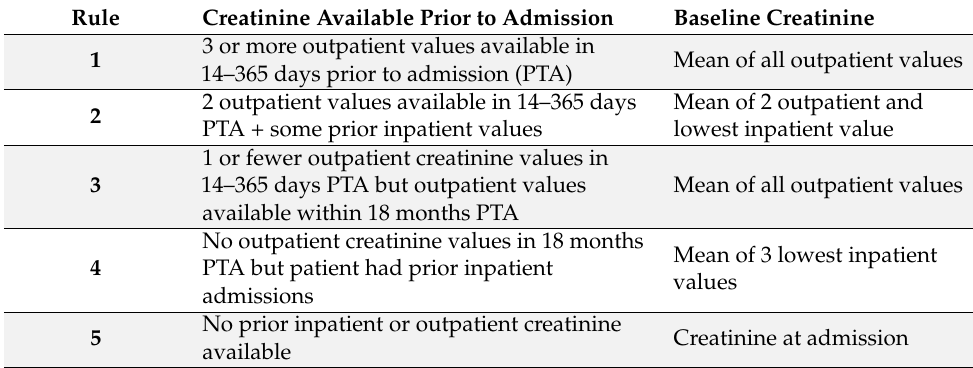
Table 1. Descending hierarchy to determine baseline creatinine. Rules in order of preference, 1 through